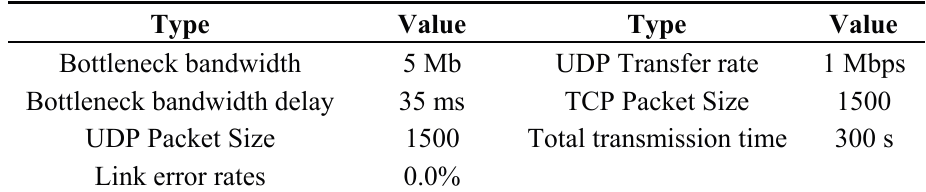
Table 3. Parameter